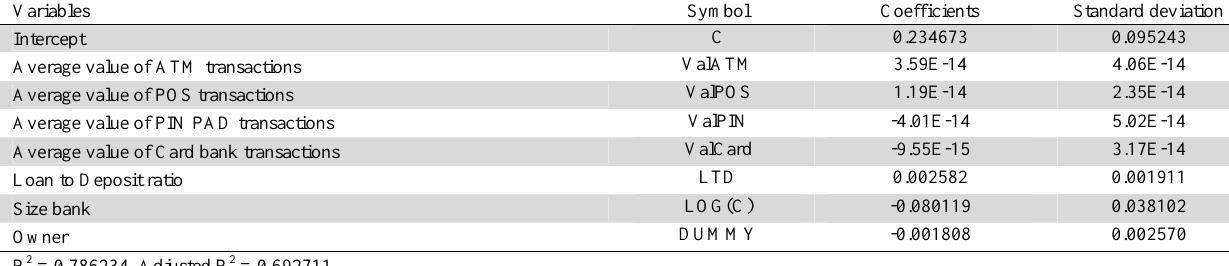
The relationship between the development of e-banking and LQGR Index